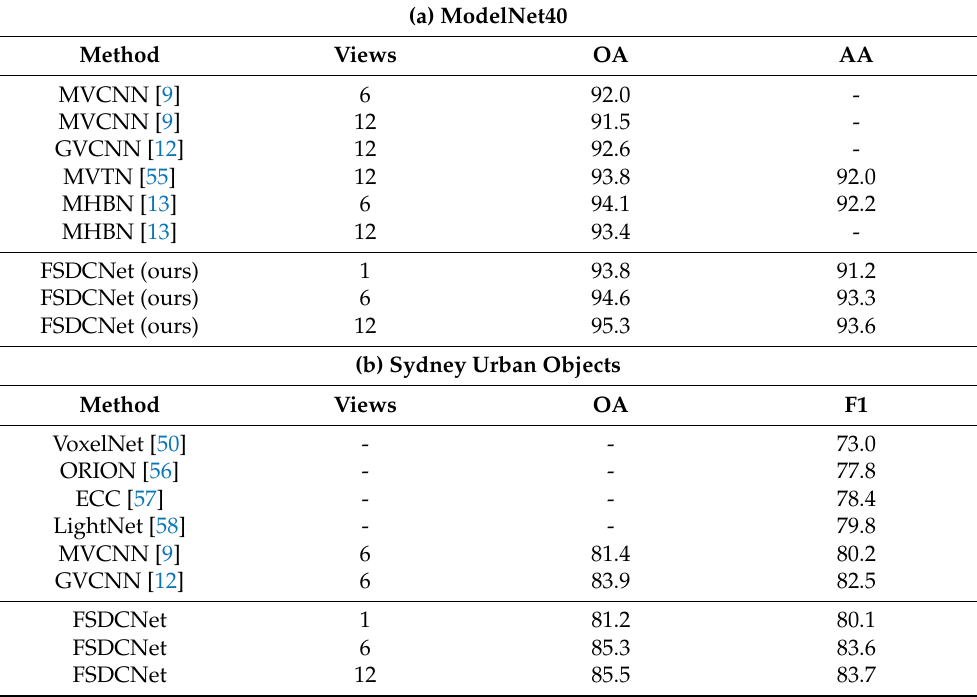
Table 4. Influence of the number of views on classification